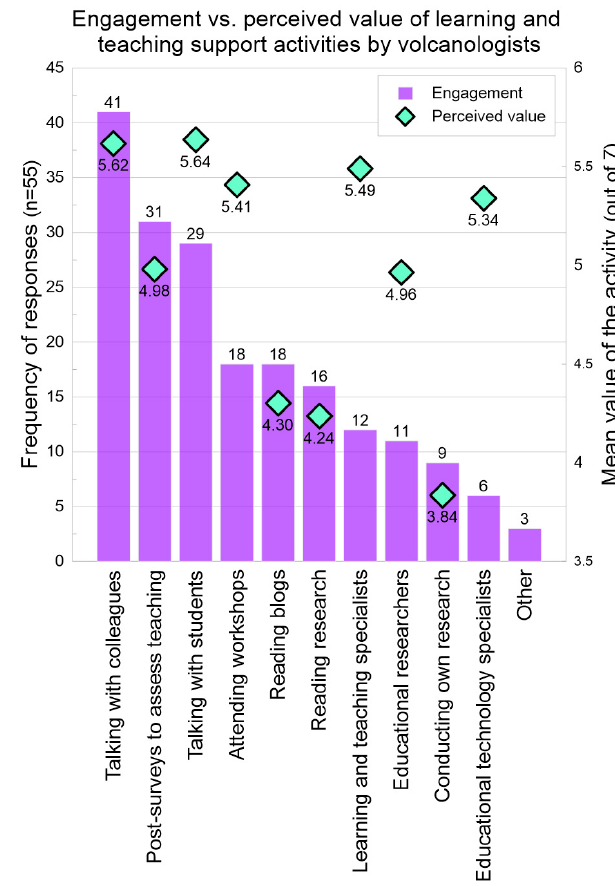
Figure 3: Resources that support respondents’ vol- canology teaching. Note that respondents could select multiple options.